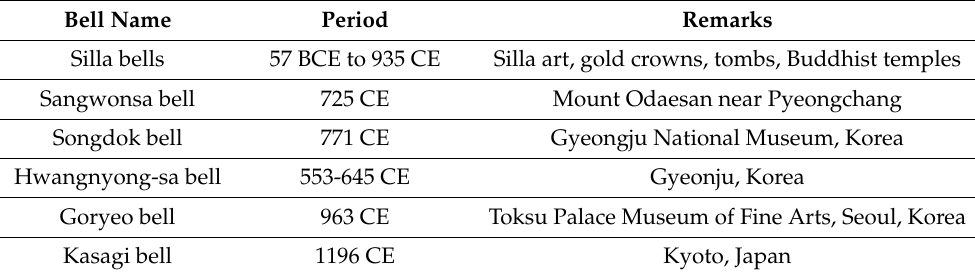
Table 1. Some common temple bells that evolved on the Korean Peninsula, data from [5,24,25].